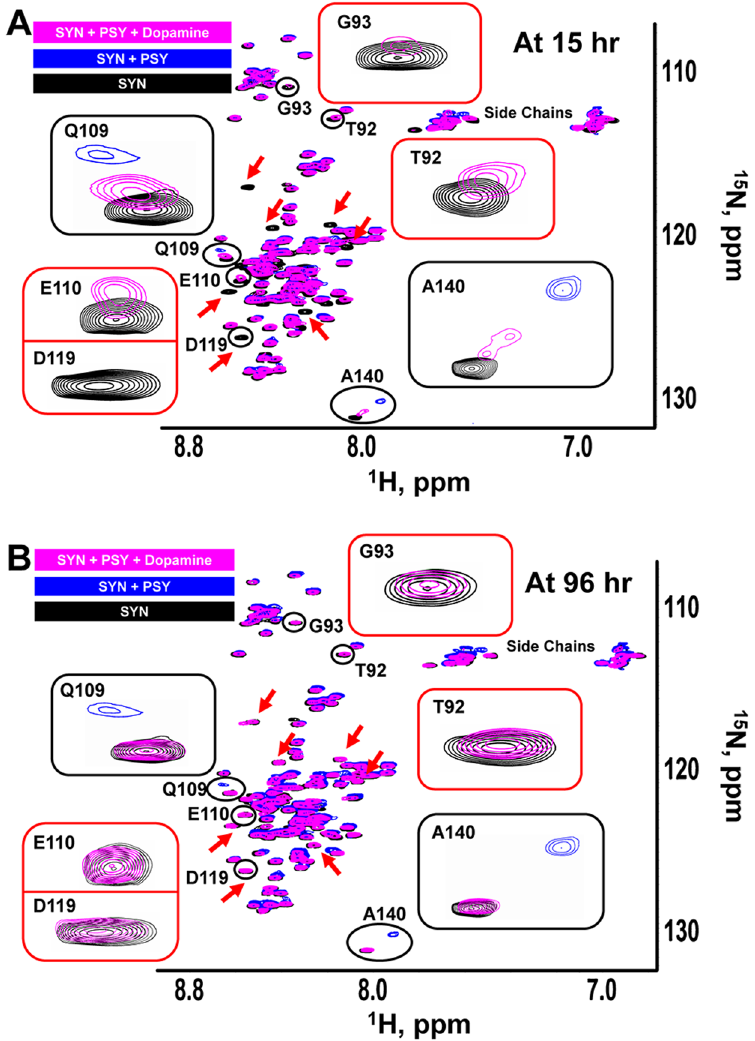
Figure 7. Dopamine blocks psychosine interaction with α -synuclein. Overlays of 1 H 15 N-HSQC NMR spectra of full-length α -synuclein (20 µ M, black) with psychosine (600 µ M, blue) and with psychosine and dopamine (600 µ M, magenta) at 15 hours ( A ) and 96 hours ( B ). Black boxes highlight chemical shift changes/reversal. Red boxes highlight signal loss/gain changes. Red arrows show the time-dependent effect of dopamine on signal broadening in the presence/absence of psychosine. PSY = psychosine; SYN = α